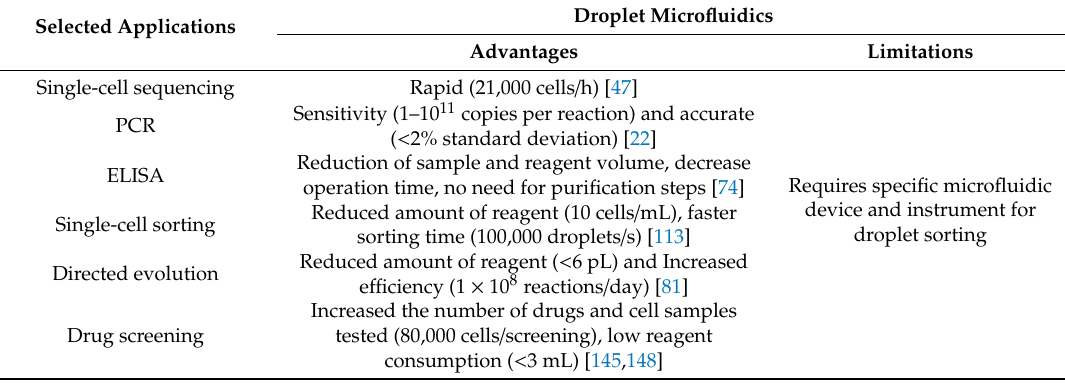
Table 2. Advantages and disadvantages of droplet-based microfluidics for selected applications. Selected